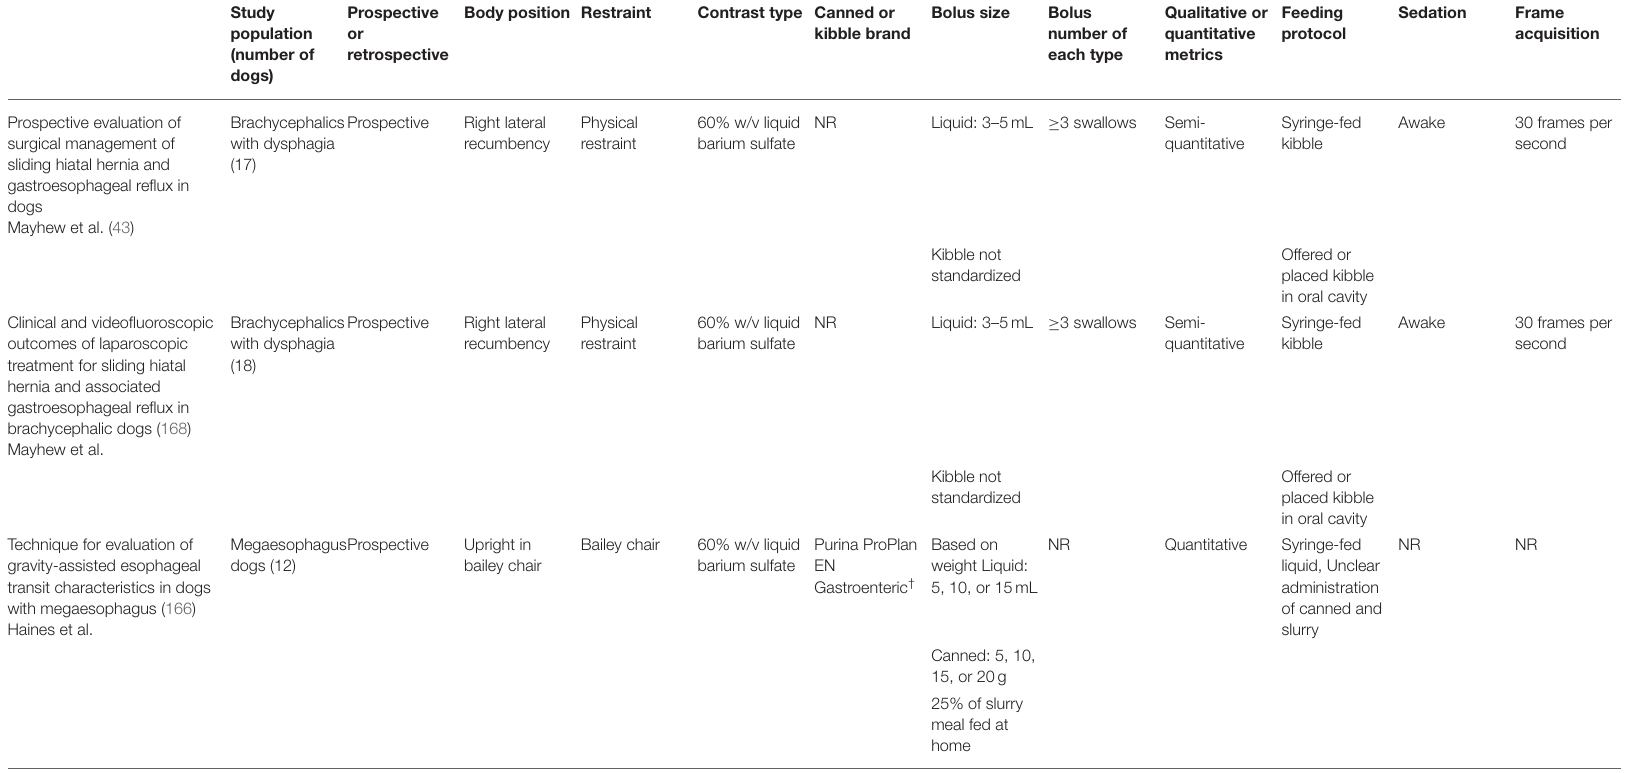
† Purina ® ProPlan ® Veterinary Diets EN Gastroenteric TM ; Nestle Purina PetCare Company, St. Louis, Missouri. * Same protocols in Inheritance of cricopharyngeal dysfunction in Golden Retrievers, Davidson et al. and Preliminary evaluation of pharyngeal constriction ratio (PCR) for fluoroscopic determination of pharyngeal constriction in dysphagic dogs, Pollard et al. NR, not